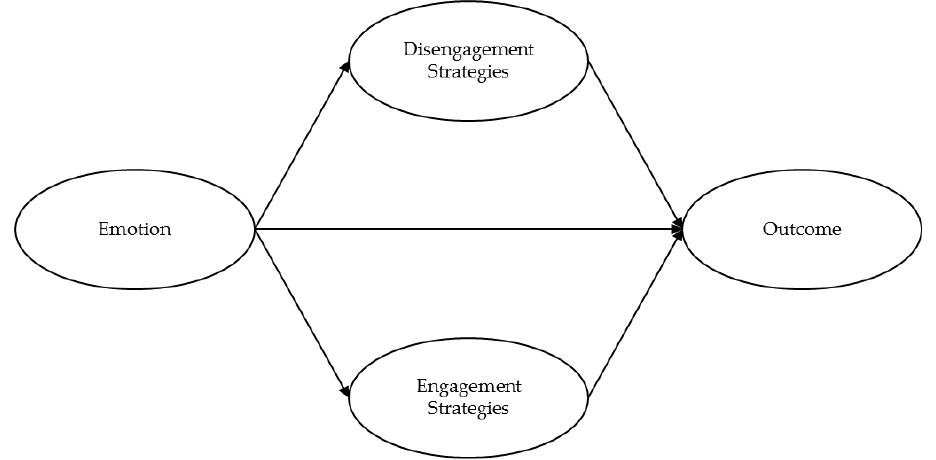
Figure 1. Emotion regulation model.